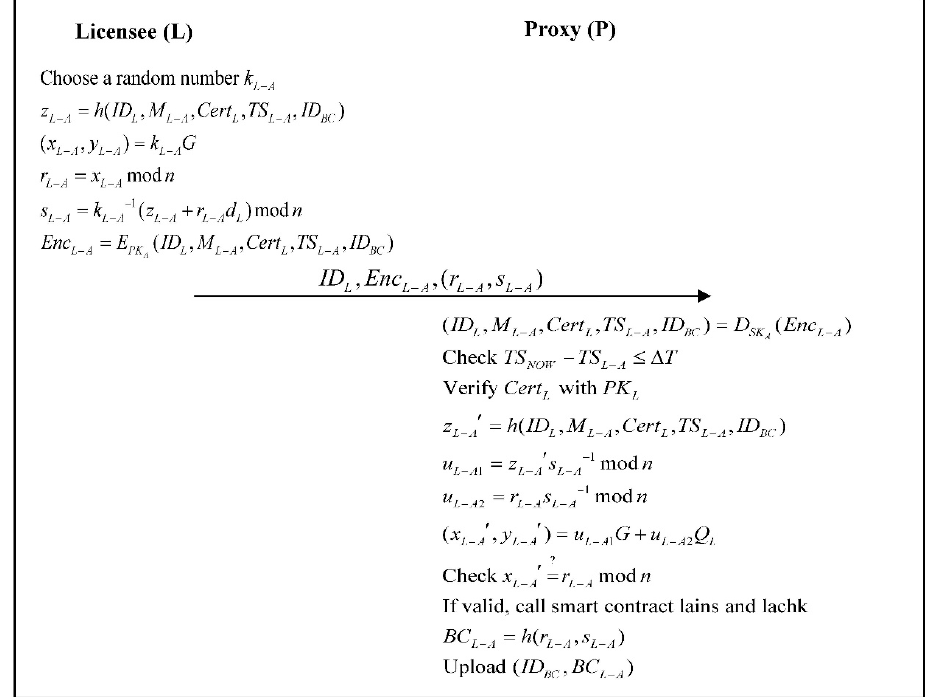
Figure 7. Authentication and issuing invoice phase (L to P).